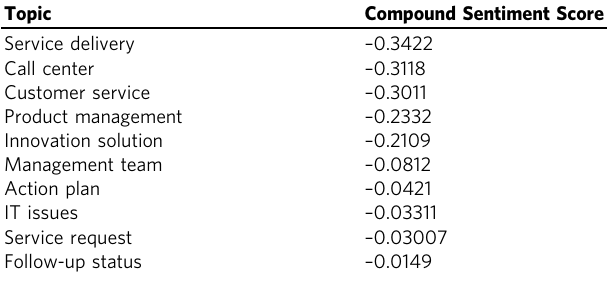
Table 4 Top 10 topics with a weighted negative score.